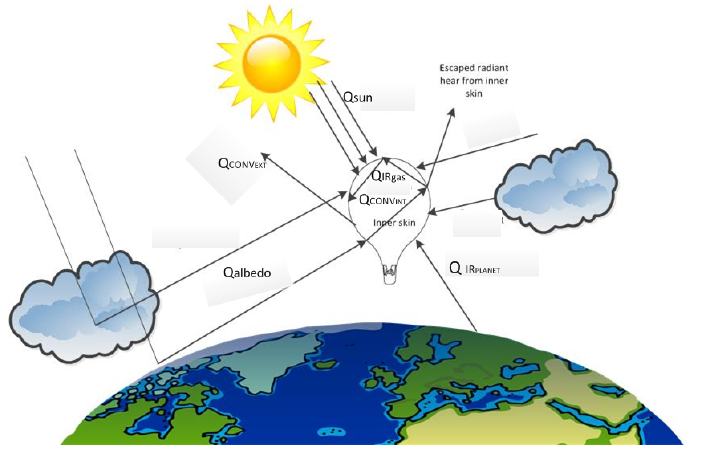
Figure 2. Radiant heat fluxes affecting the balloon flight. This figure is inspired from